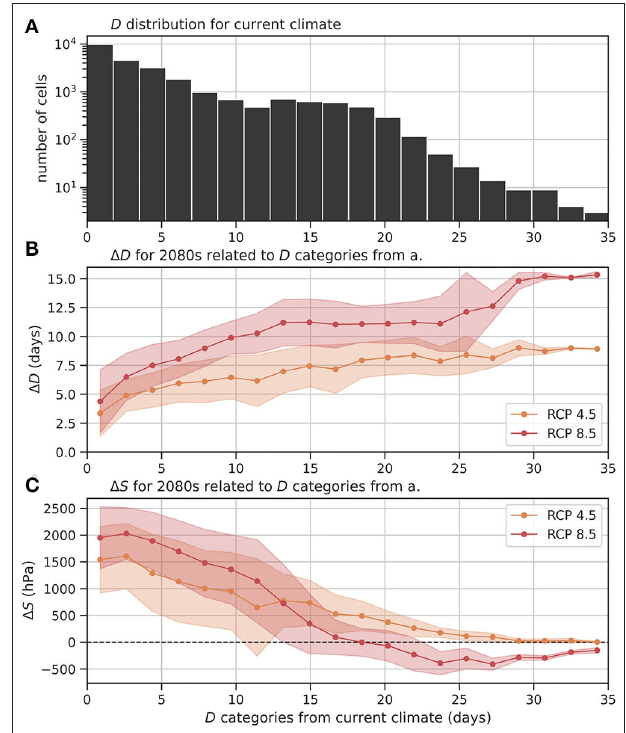
FIGURE 2 | Frequency distribution of duration D of soil water stress for the current climate (1981–2010) for the growing season (MJJASO) (A) , associated projected changes in the duration 1 D (B) , and in the severity 1 S (C) in 2080s (2071–2100) calculated for RCP4.5 and RCP8.5 for categories (bins) defined in (A) . In (B,C) , points represent the mean of the projected changes for each category of the histogram (A) and the band represents the mean value plus and minus one standard